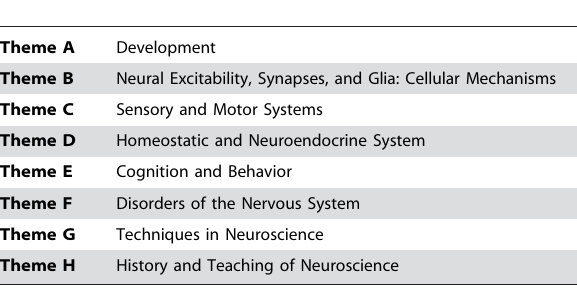
Table 5. Themes used by SFN to categorize abstracts